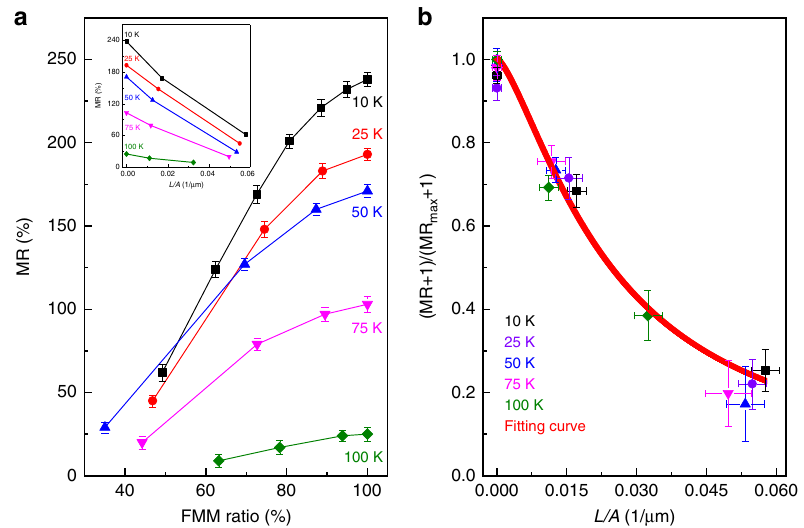
Fig. 5 Nonlinear increase of MR response in LPCMO-OSV as a function of FMM ratio and phase boundary length per FMM area at different temperatures. a Obtained MR response as a function of FMM ratio controlled by applying different pre-set magnetic fi eld ( B pre ). The inset shows the change of MR response as a function of the total length of phase boundary per FMM area (i.e., L/A ratio). The L/A ratios are calculated from the MFM images in Fig. 4 (i.e., FMM-fraction of red area; the total length of phase boundary per unit- fraction of white area per 10 μ m×10 μ m) at 10 K, 25 K, 50 K, 75 K, and 100 K after applying the pre-set magnetic fi eld, B pre = 1 T, 3 T, and 7 T, respectively. b Calculated MR þ 1 using the Eq. (2) as a function of L/A ratio, consistent MR max þ 1 with the experimental results in the inset of panel a . MR measurements were taken at V = 0.2 V. The vertical error bars in MR represent the nondeterminacy of the MR measurements and the fi tting value of MR max , the lateral error bars in L/A represent the statistical uncertainty of the MFM measurements of L and A